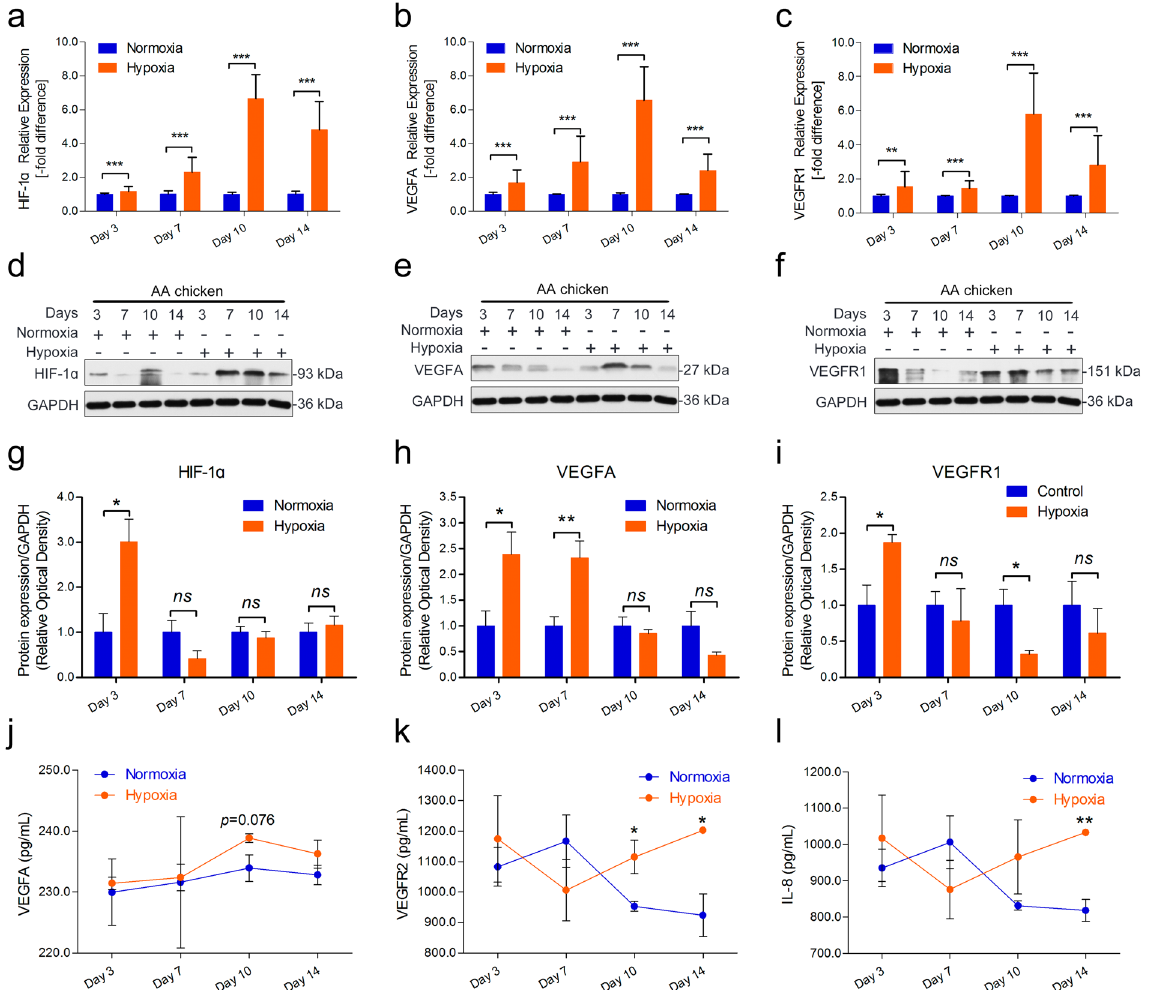
Figure 5. Hypoxia enhances angiogenesis-related mRNA and protein expression. ( a – c ) The mRNA expression levels of HIF-1 α , VEGFA, and VEGFR1 were determined by qRT-PCR. mRNA expression levels from the normoxia group were normalized to 1. GAPDH was used as the loading control. The results are representative of at least three independent experiments, which were run in triplicate, and are expressed as the mean ± SD. Student’s t -test, * p < 0.05, *** p < 0.001, n = 3. ( d – f ) The protein expression levels of HIF-1 α , VEGFA, and VEGFR1 were determined by Western blotting. ( g – i ) The results of the western blots were quantified and analyzed using Image-Pro ® Plus 6.0. Student’s t -test, * p < 0.05, ** p < 0.01, n = 3; Error bars indicate SEM. ns, not significant. ( j – k ) The serum concentrations of VEGFA, VEGFR2, and IL-8 were measured using an ELISA kit. Student’s t -test, n ≥ 3; Error bars indicate